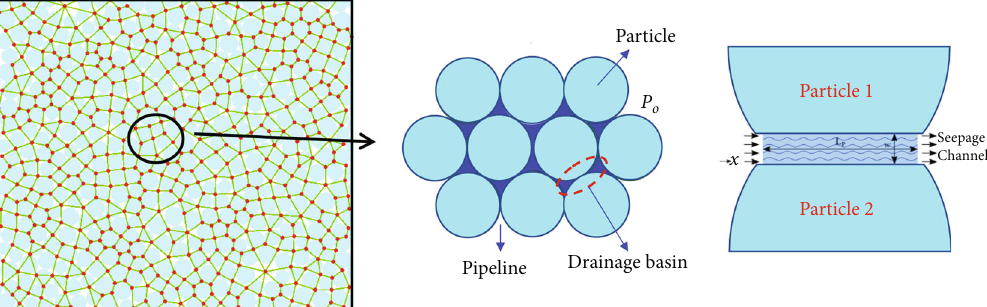
Figure 2: Fluid-solid coupling model in PFC 2D